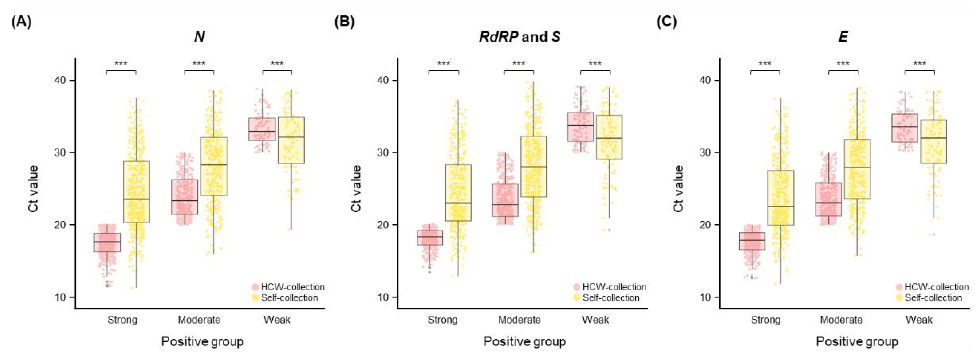
Figure 3. Distribution of the Ct values for SARS-CoV-2 in concordant positive specimens ( n = 850). Boxplot of ( A ) N , ( B ) RdRP and S , and ( C ) E . The box plots present the median (interquartile range) values. *** p < 0.001.